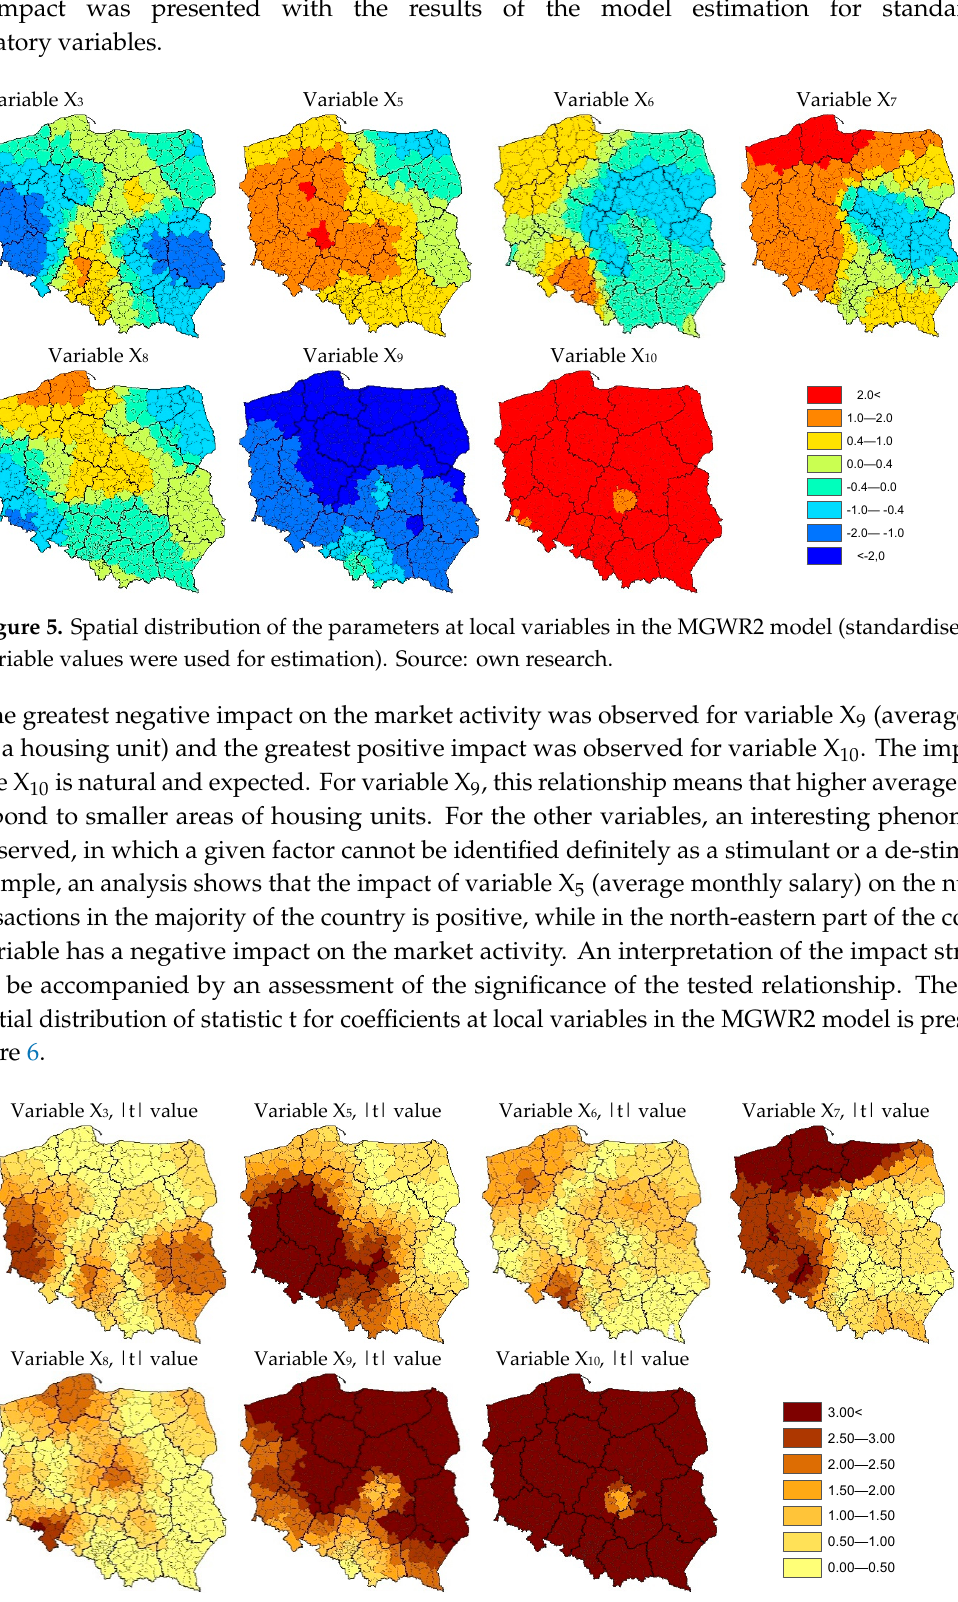
Figure 6. Spatial distribution of statistic t for coefficients at local variables in the MGWR2 model. Source: own research.